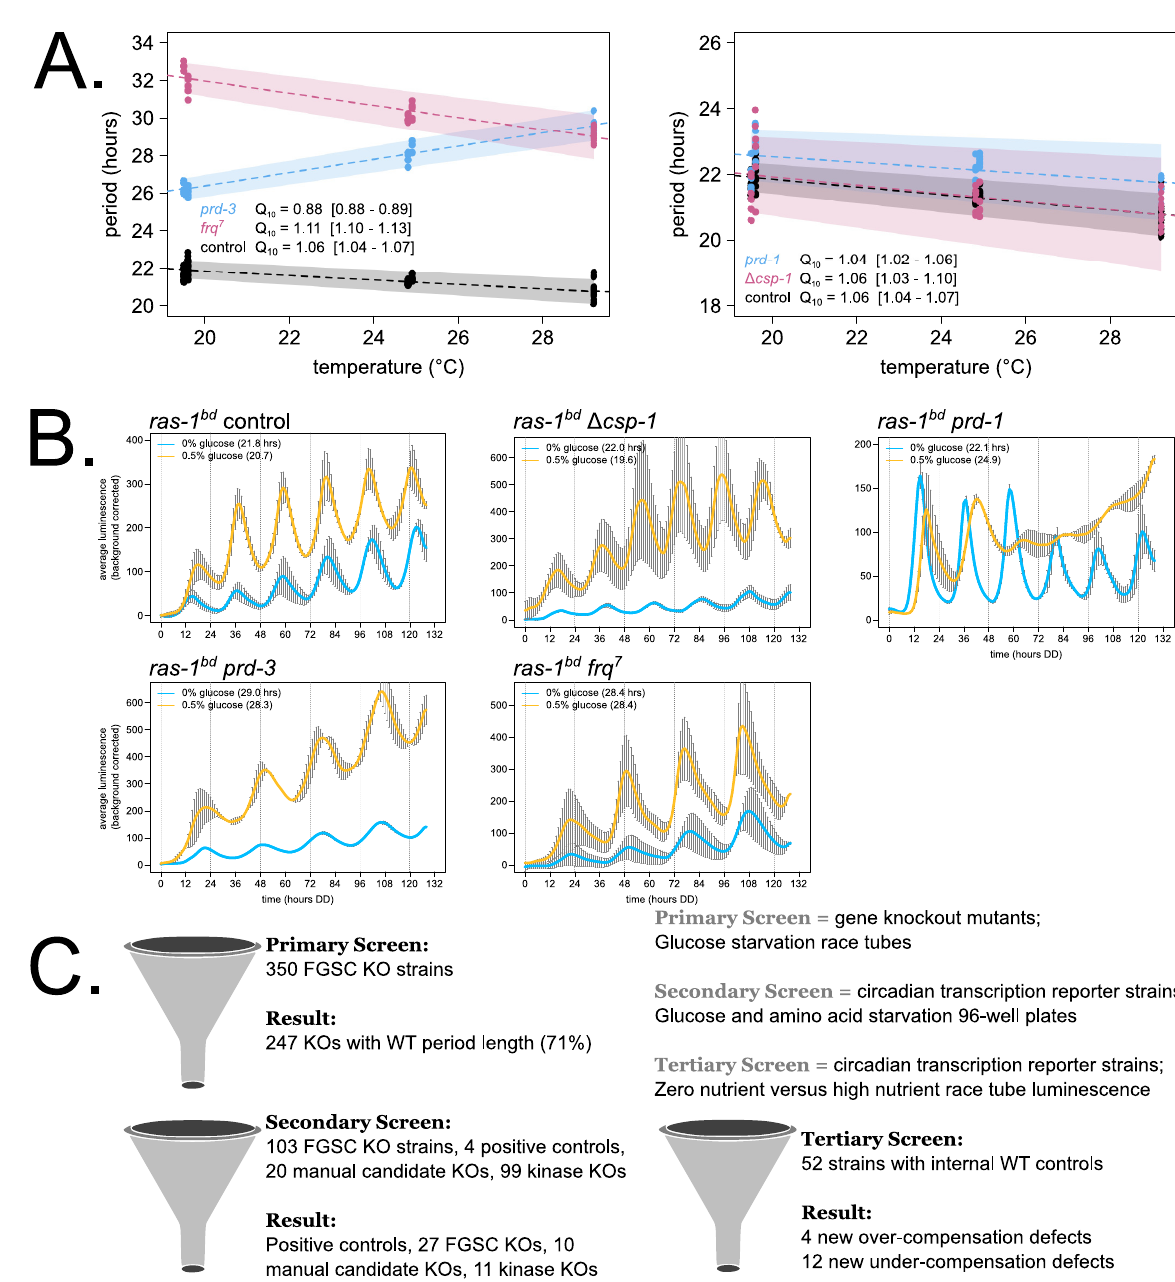
Fig 2. Nutritional Compensation mutants have normal Temperature Compensation in Neurospora , catalyzing a genetic screen for new mutants. To measure the circadian period length across temperatures in constant darkness, 96-well plate luciferase assays were used ( N = 12 replicates per strain, per temperature). A linear model was fit to period length data from each strain (glm in R), and a Q 10 temperature coefficient was calculated using the model-fitted period lengths at 20˚C and 30˚C. Shaded areas around the linear fit represent the 95% confidence intervals on the slope. Error ranges on Q 10 values were computed from the 95% CIs ( A ). Circadian bioluminescence was recorded from race tube cultures of the indicated genotypes, as previously described [51] (S1 Movie). High nutrient medium (yellow lines) contained 0.5% w/v glucose 0.17% w/v arginine, and zero nutrient medium (blue lines) contained 0% glucose 0% arginine (standard deviation error bars). Period lengths, indicated as insets, were computed from N = 2–5 biological replicates per nutrient concentration ( B ). Cartoon depiction of the 3-phase genetic screen for Nutritional Compensation defects among kinase, RNA regulatory proteins, and manual candidate knockout strains ( C ). FGSC = Fungal Genetics Stock Center, curator of the Neurospora whole genome knockout collection. The raw data underlying parts ( A ) and ( B ) can be found in S2 Data.